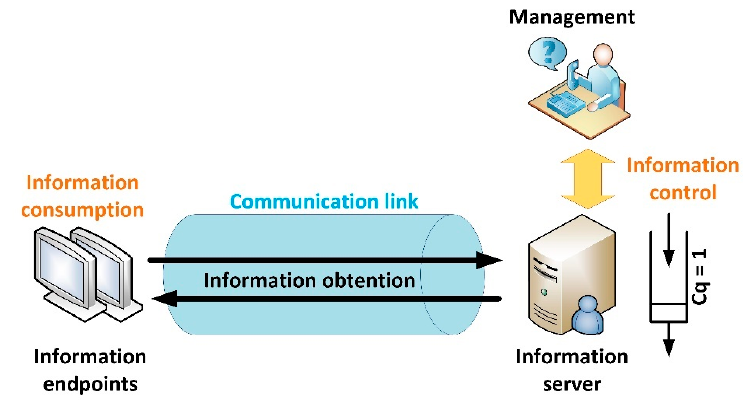
Figure 1. Architecture for a communication endpoint-server link in Smart Homes.